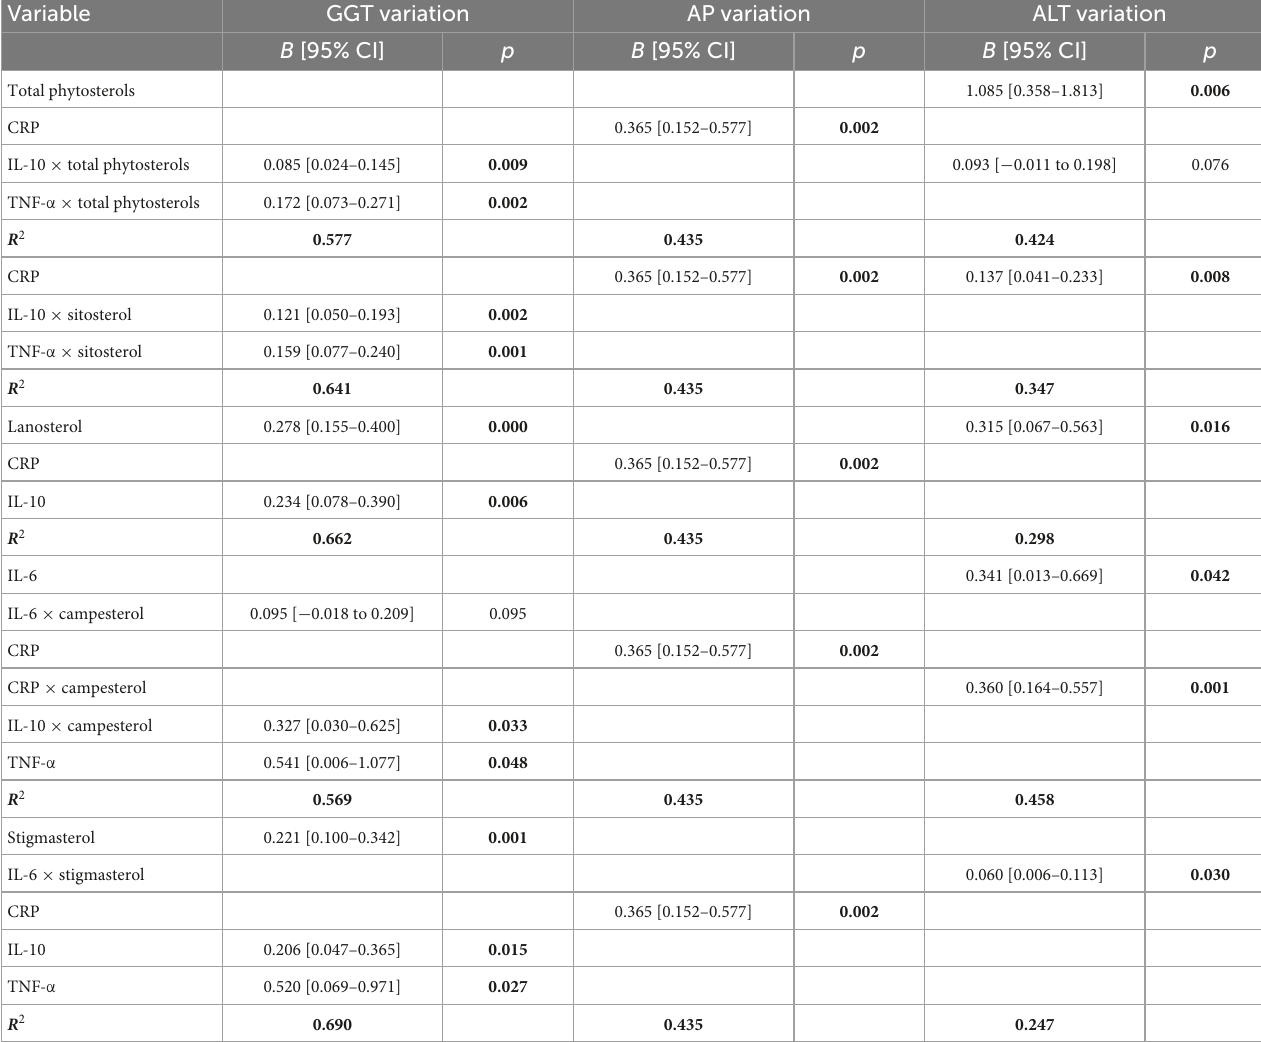
TABLE 4 Multiple linear regression. Stepwise: differences between liver parameter variations and risk factors ( p < 0.2).